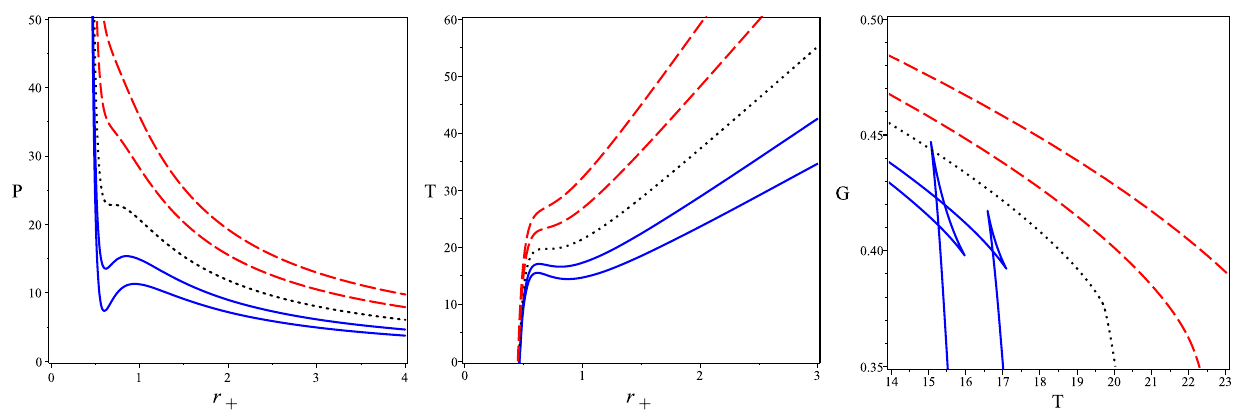
Fig. 17 LM AdS black hole with spherical horizon: P − r + (left), T − r + (middle) and G − T (right) diagrams; we have set k = 1, d = 7, q = 1, m = 1, c = c 1 = c 2 = c 3 = c 4 = 1 and α = 0 . 01. Left panel: